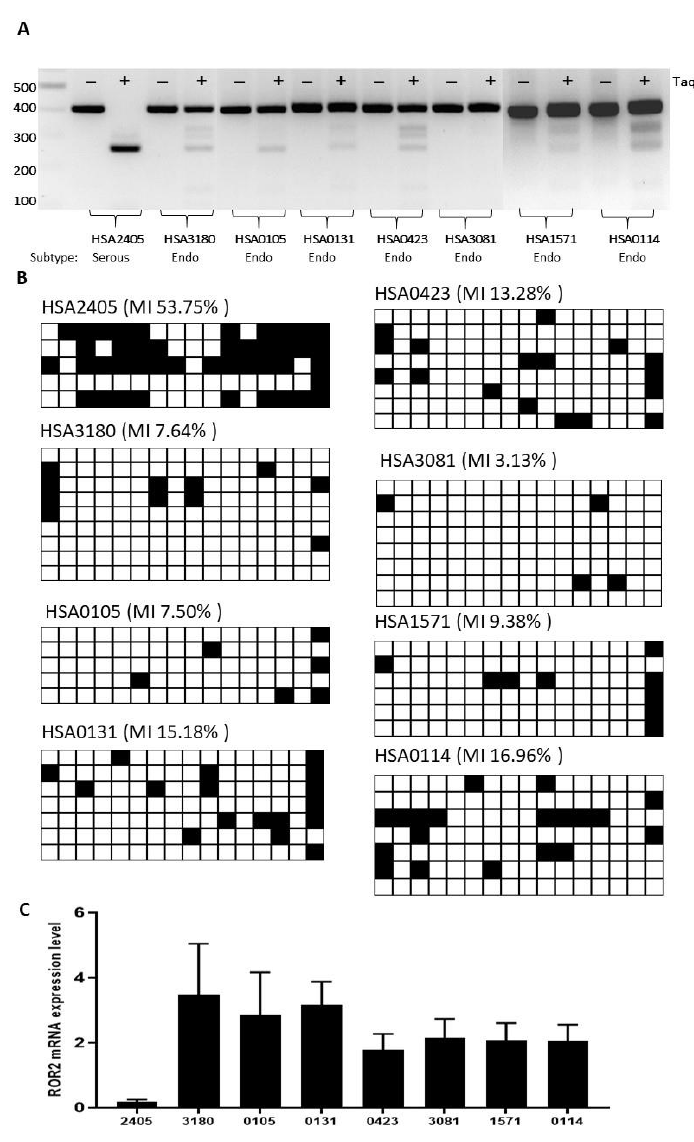
Figure 5. ROR2 expression was correlated with promoter methylation index (MI) in EC patient samples. ( A ). COBRA assay of 8 patient samples showing PCR amplicons (395 bp) with and without TaqI digestion. HSA2405 sample showed complete digestion of the amplicon, which indicated existence of methylation. ( B ). Bisulphite genomic sequencing results of 8 EC patient samples. HSA2405 showed higher methylation level than other cases. ( C ). ROR2 mRNA expression in 8 EC patient samples as measured by qRTPCR and normalised to 3 housekeeping genes ( n = 3). The serous EC patient HSA2405 which showed digestion in the COBRA assay and high methylation level showed low ROR2 expression by